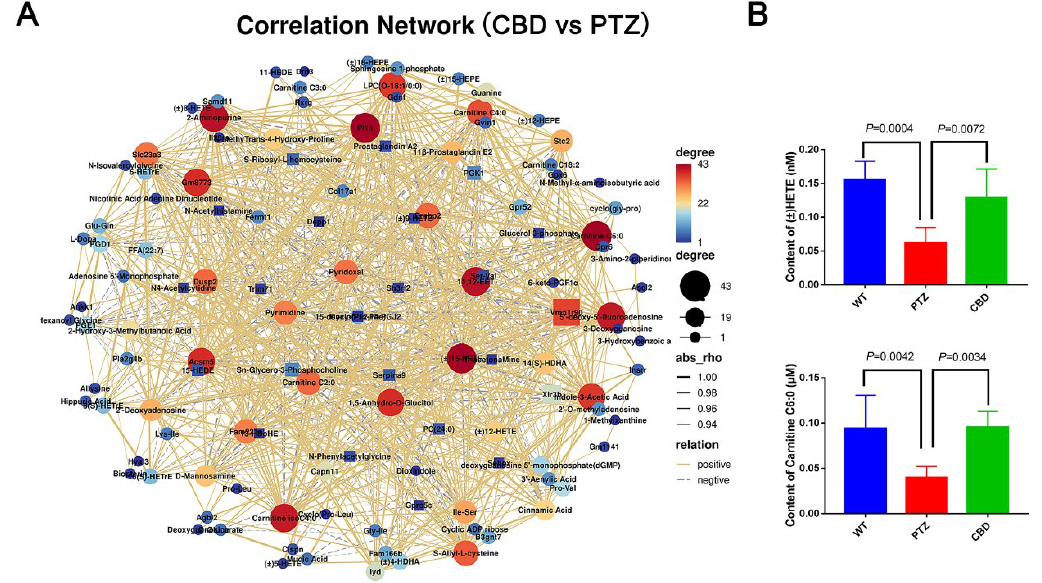
Figure 8. Correlation analysis of transcriptome and metabolome. ( A ) The correlation network between the CBD group and PTZ group. ( B ) The content of (+/ − )15-HETE and carnitine C6:0 in hippocampus of mice in each group. n = 6, the error bar represents SD.